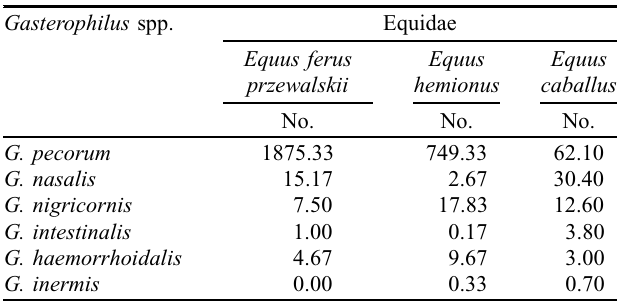
Table 3. Abundance intensity of Gasterophilus spp. larvae in three equids in Kalamaili Nature Reserve, China. Gasterophilus spp.